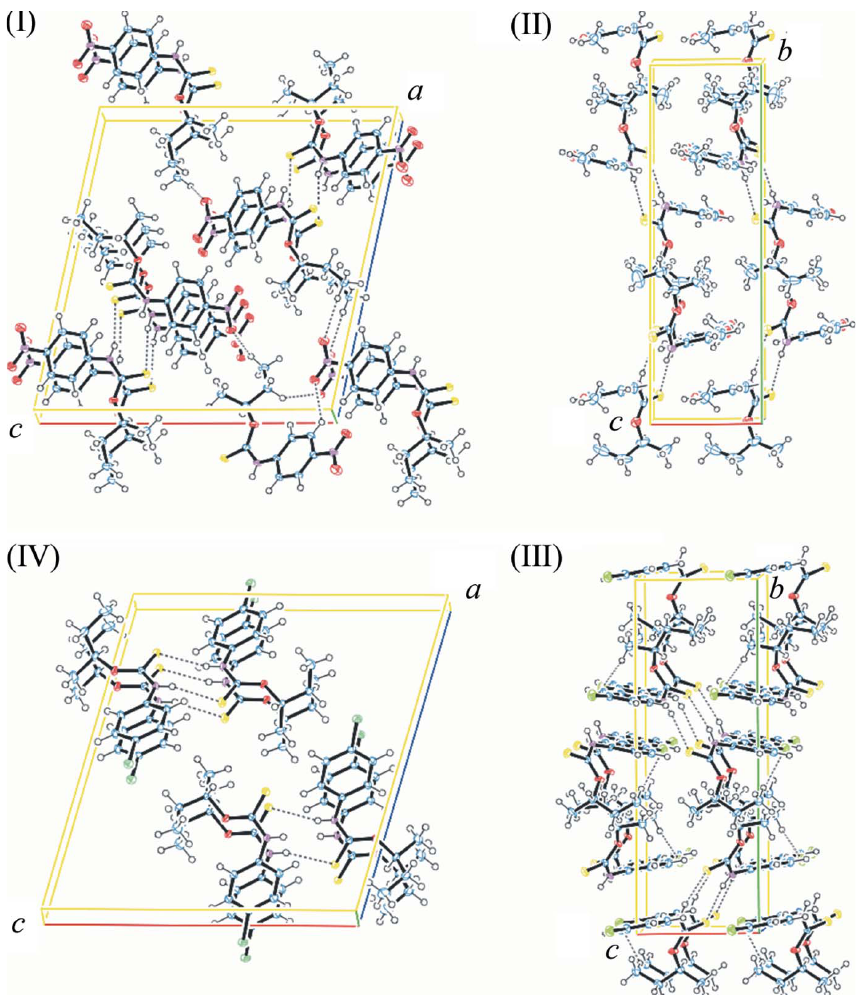
Figure 2 Packing of the structures of this report. (I), (IV): view slightly inclined to the b axis (cid:2) (II), (III): view approximately along the a axis. Disorder omitted for